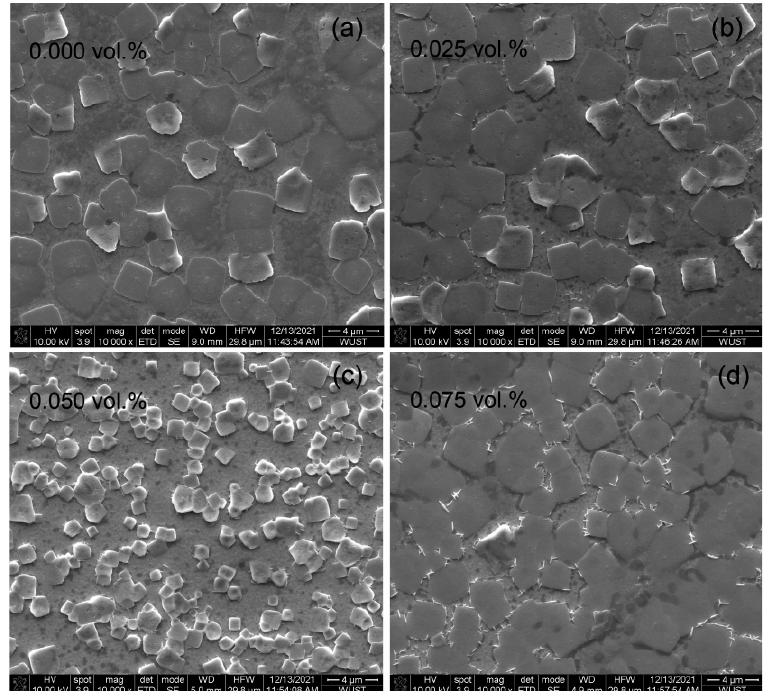
Figure 4. The SEM images of CH 3 NH 3 PbBr 3 films ( a ) without PMA doping, ( b ) with 0.025 vol.% PMA, ( c ) with 0.050 vol.% PMA, ( d ) with 0.075 vol.% PMA.